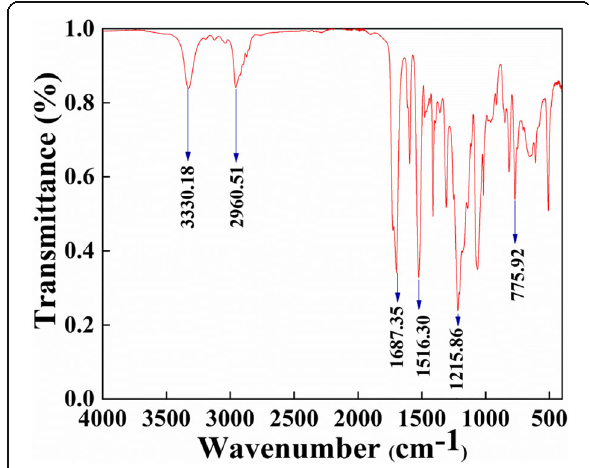
Fig. 3 Composition of TPU nanofiber membrane. FTIR demonstration of TPU indicating the presence of various functional